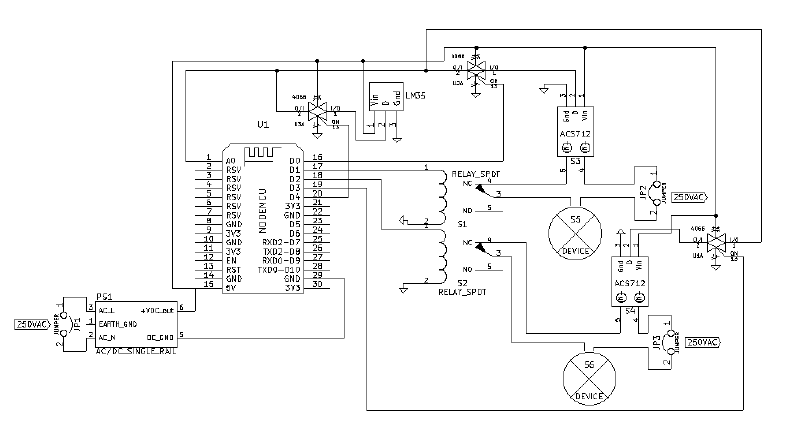
Figure 5. Electronic schematic of the actuator node.